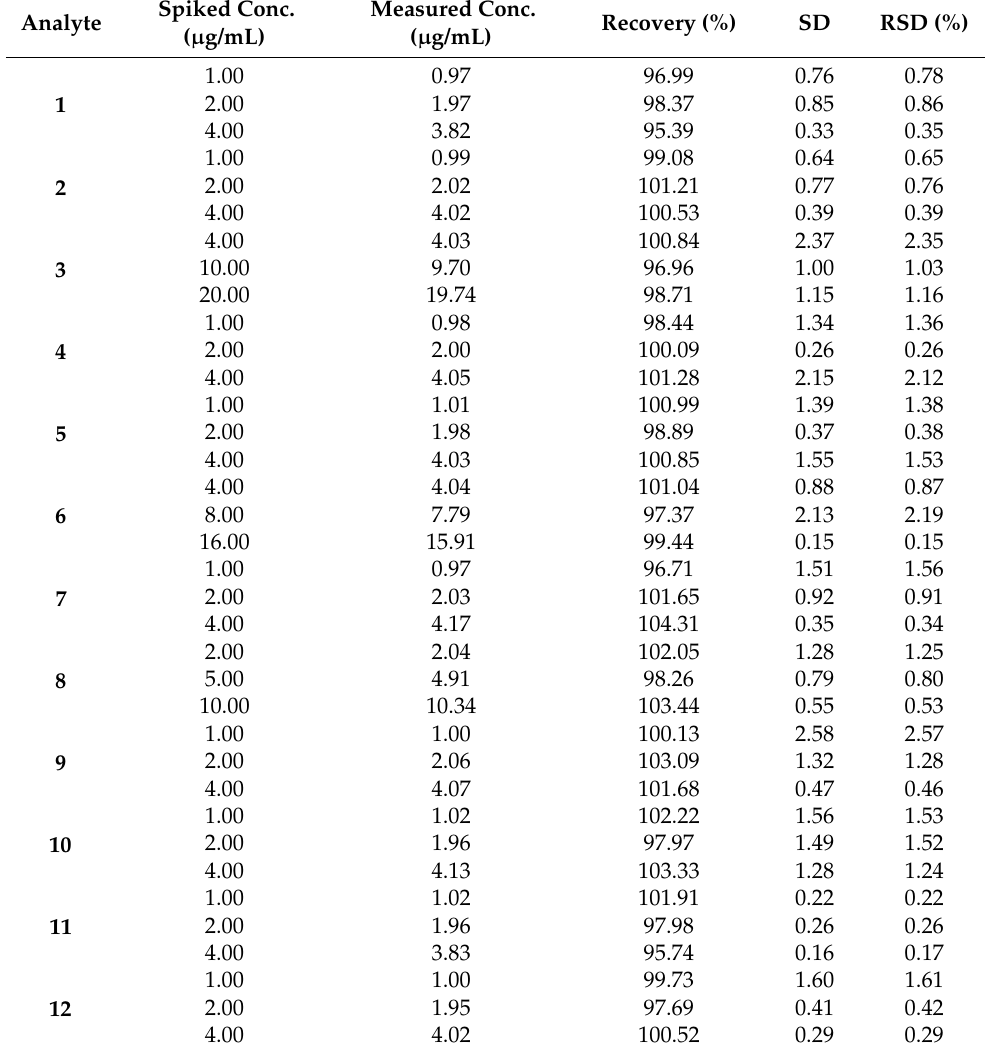
Table 4. Recovery test results (%) for the 12 markers determined using the HPLC method ( n = 5). Spiked Analyte